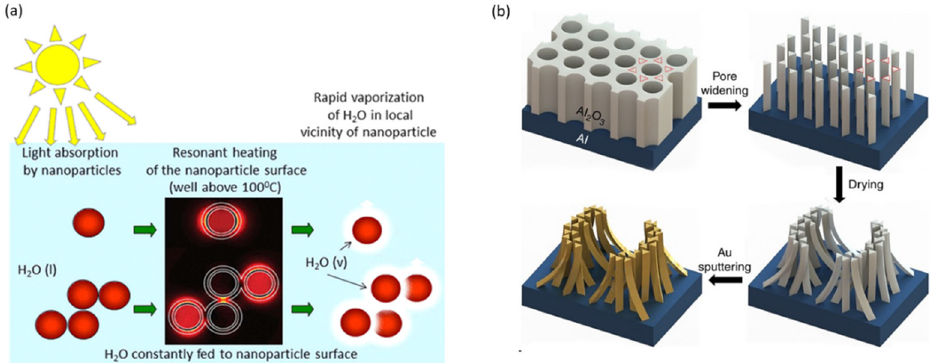
Figure 4. ( a ) SiO 2 /Au nanoparticles and ( b ) schematic illustration for prepare black gold membranes by using pore-widening method into hexagonal anodic aluminum oxide (AAO) templates. ( a ) Reprinted with permission from Ref. [45]. Copyright 2013 American Chemical Society. ( b ) Reprinted from Ref. [53] (open